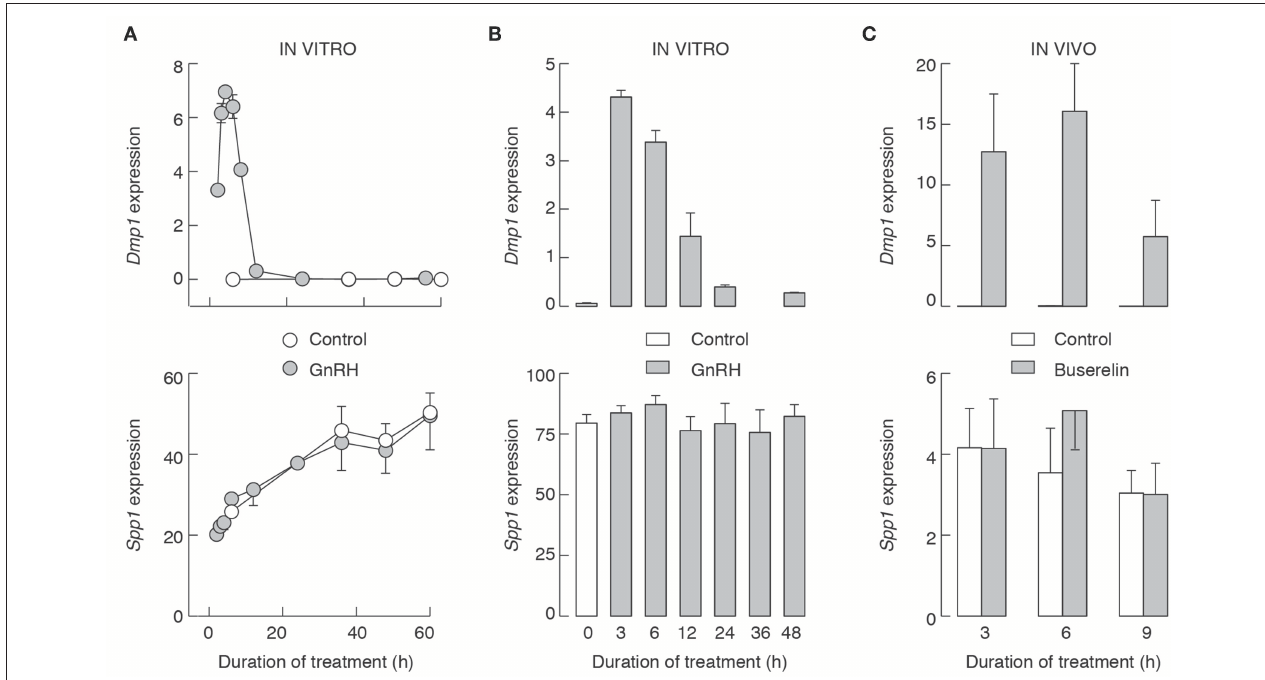
FIGURE 10 | The lack of an effect of GnRHR activation on Spp1 expression in vitro (A,B) and in vivo (C) . Experiments were performed with 7-week-old females. (A) Pituitary cells were cultured overnight in medium 199 containing horse serum, washed in the morning, and cultured in medium 199 supplemented with BSA with or without 10nM GnRH for 0–60h prior to the end of experiments, and samples were analyzed for Dmp1 (top) and Spp1 (bottom) mRNA expression. (B) 96h old cell cultures were treated as described in (A) , up to 48h, and samples were analyzed for Dmp1 (top) and Spp1 (bottom) mRNA expression. (C) Animals were injected with buserelin acetate or solvent as described above. Gray bars and circles, GnRH/buserelin acetate-treated cells/animals; white bars and circles, solvent-treated